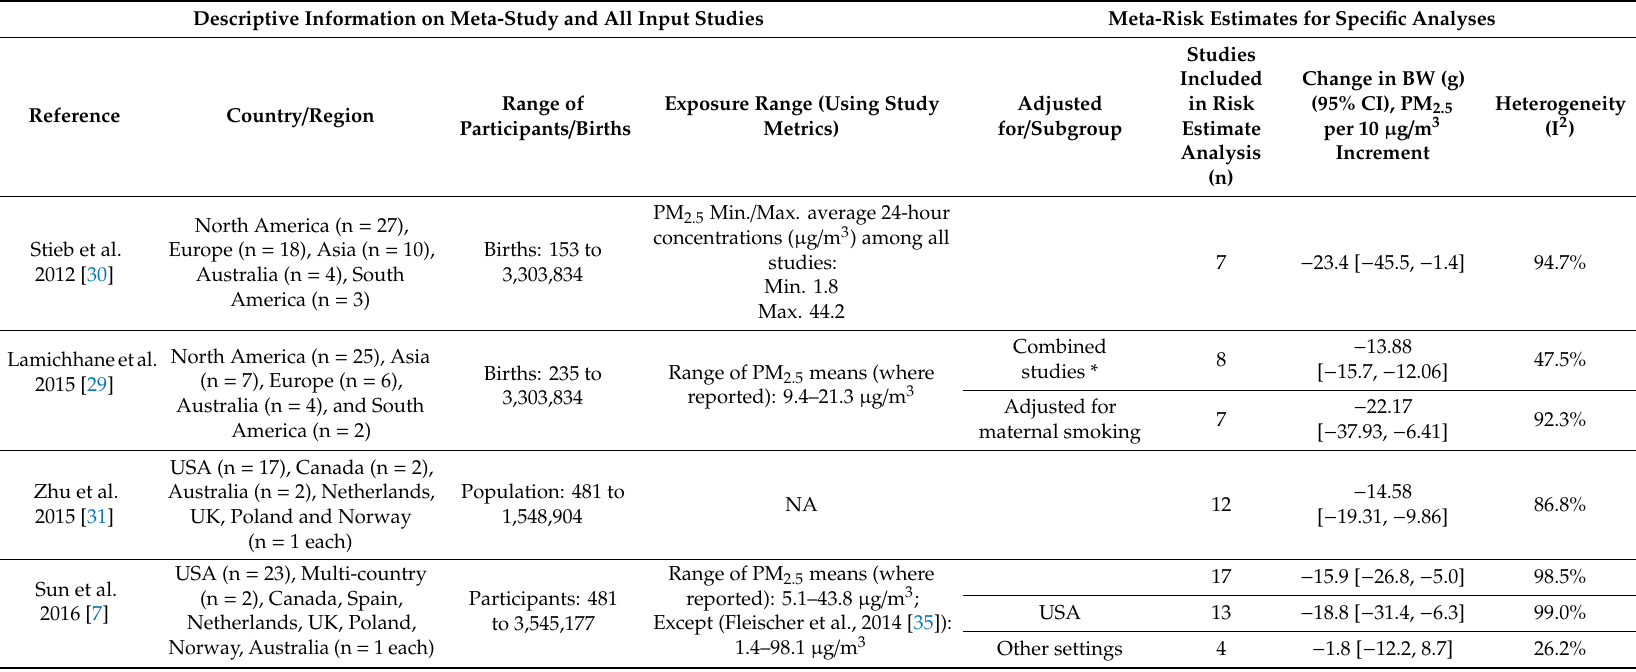
Table 2. Meta-analyses results for change in BW (g) and PM 2.5 exposure during the entire